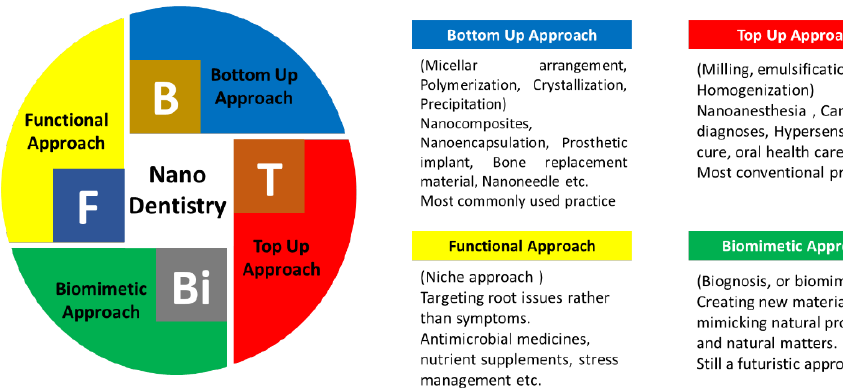
Figure 2. Various synthesis approaches implemented in nanodentistry.